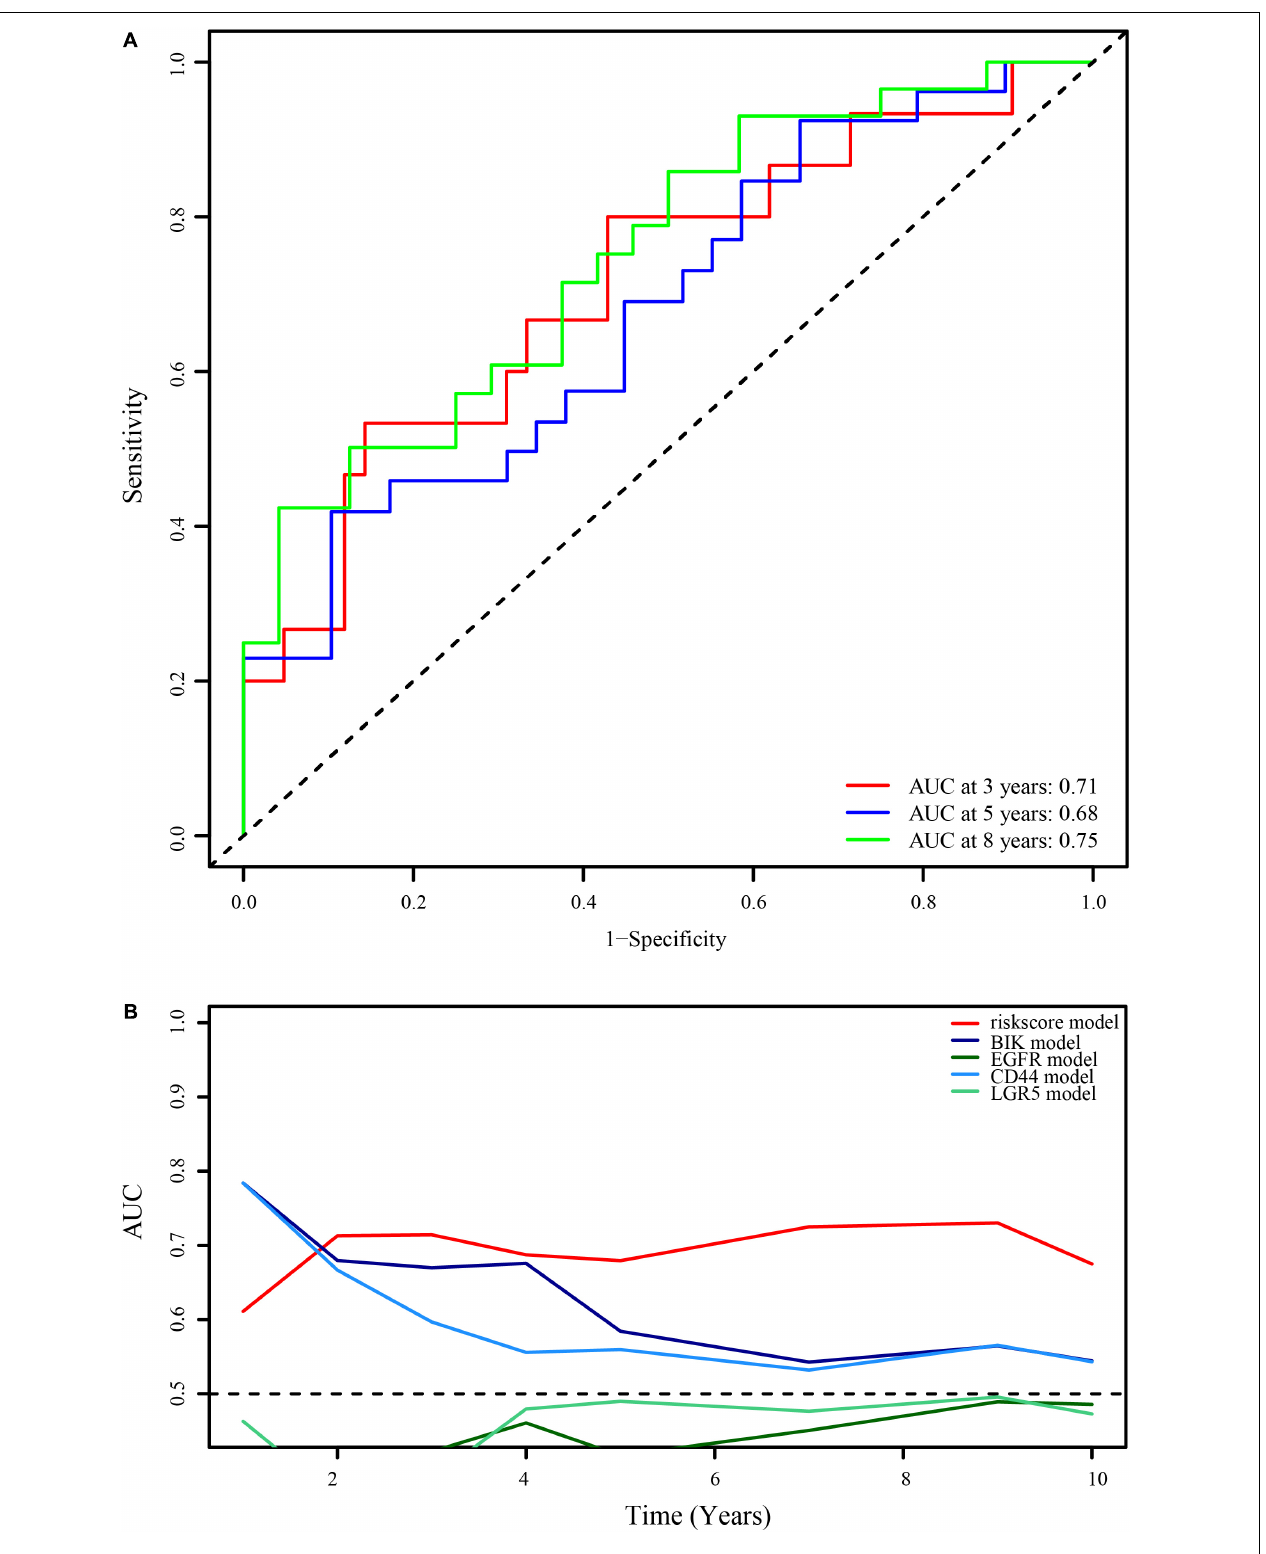
FIGURE 5 | Verification of the optimal immune-related 11-lncRNA signature. (A) 3-, 5-, and 8-year ROC curves of the 11-lncRNA signature in the external verification set. (B) Comparison of the 11-lncRNA signature and common prognostic biomarkers of ES.